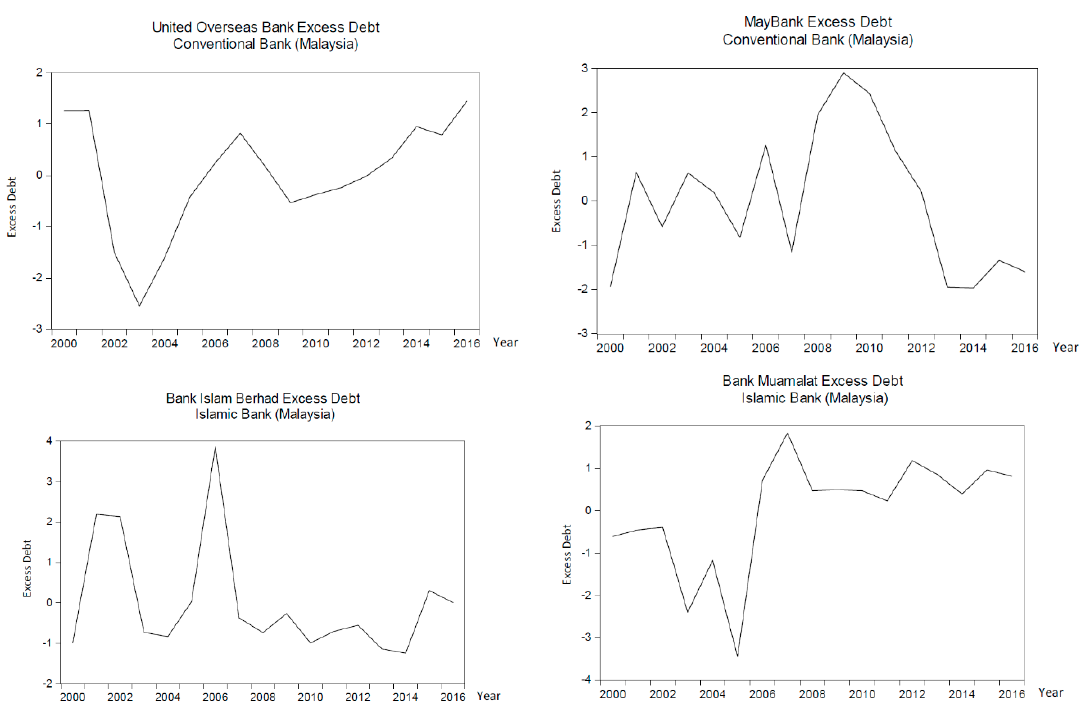
Figure 8. Malaysia excess debt. Source: Author’s calculations.